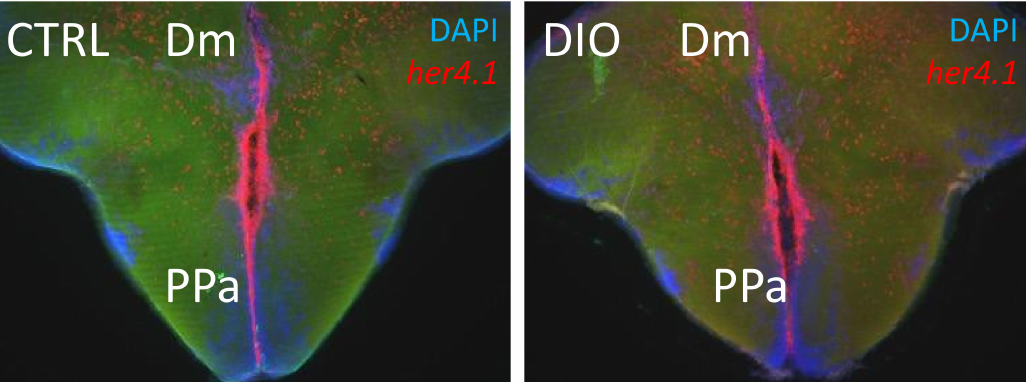
Figure 3. her4.1 in situ hybridization on brain section of CTRL and DIO fish. Preliminary data on DIO fish (4 weeks) did not show striking differences in the expression of the Notch target gene, her4.1 (red), in CTRL and DIO fish. Cell nuclei were counterstained with DAPI (blue). Dm: dorsomedian telencephalon. PPa: anterior part of the preoptic